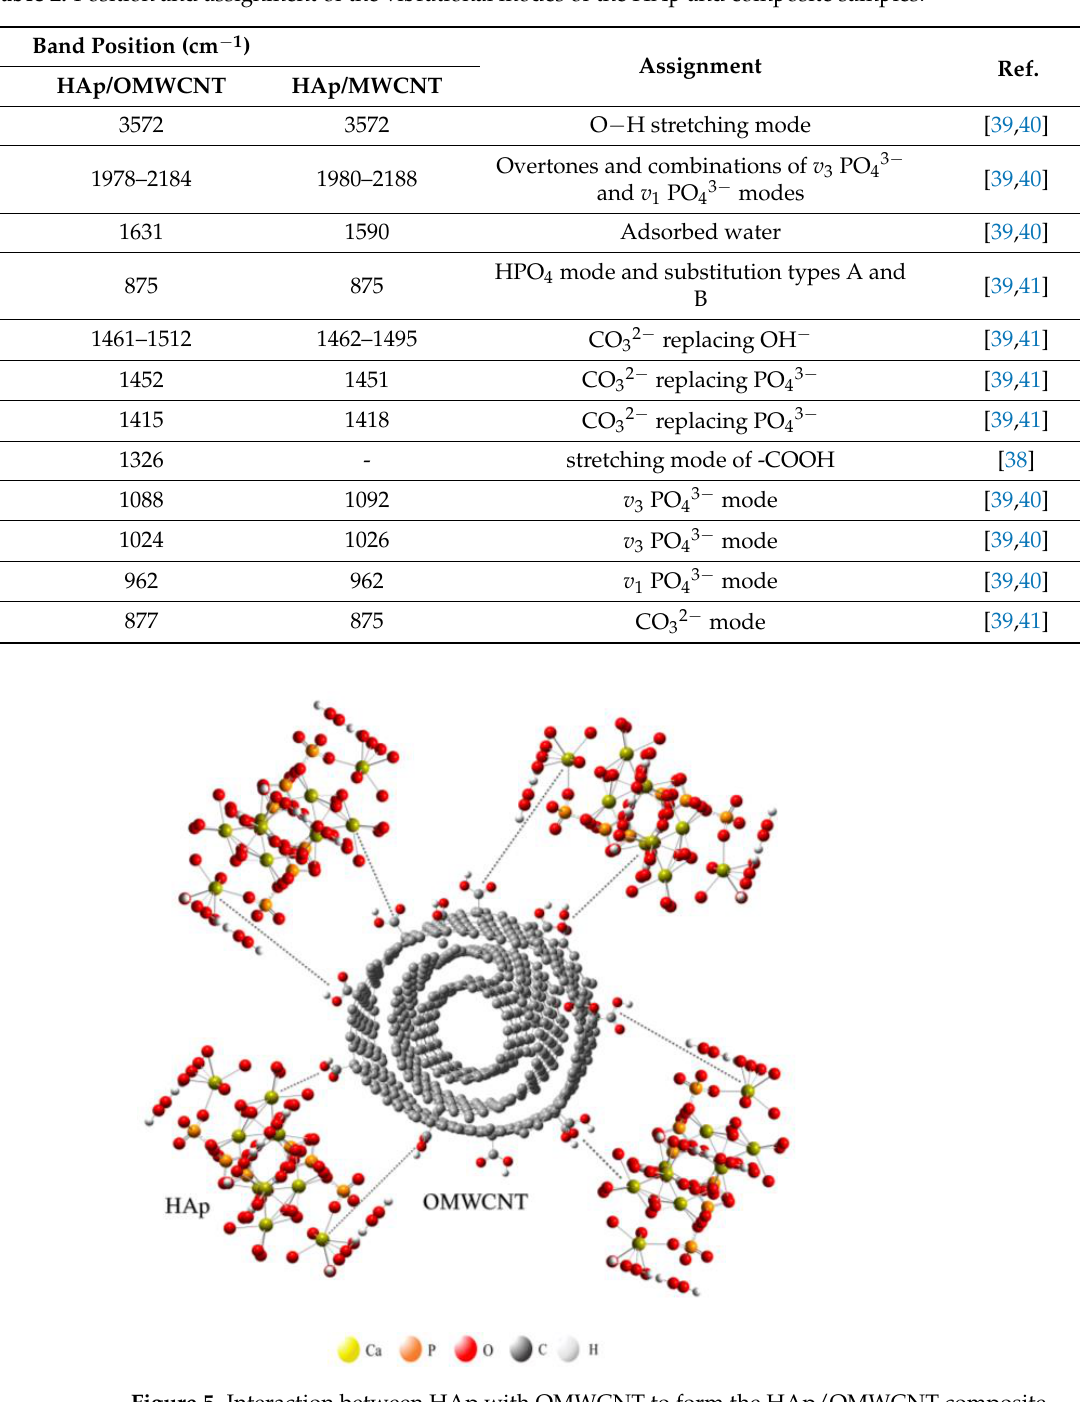
Figure 5. Interaction between HAp with OMWCNT to form the HAp/OMWCNT